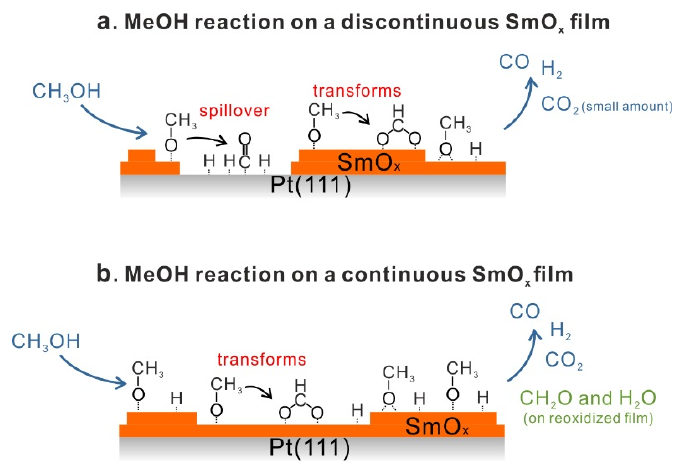
Figure 10. Summary of the MeOH reaction on ( a ) a discontinuous SmO x thin film, and ( b ) a continuous SmO x thin film.